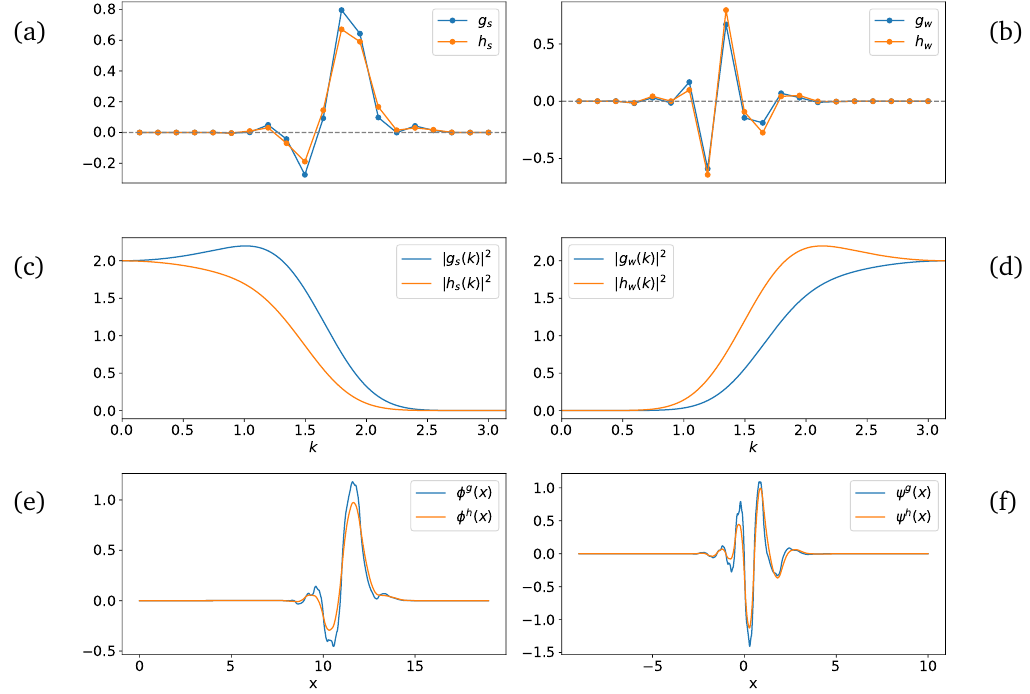
Figure 5: The results of using K = 2, L = 4 in the construction of Eq. (30): (a) scaling filters g and h , (b) wavelet filters g and h , (c) absolute value squared of the Fourier s s w w ( k ) | 2 and | h ( k ) | 2 , (d) absolute value squared of the transforms of the scaling filters | g s s ( k ) | 2 and | h ( k ) | 2 , (e) scaling functions φ g Fourier transforms of the wavelet filters | g w w and φ h , and (f) wavelet functions ψ g and ψ h